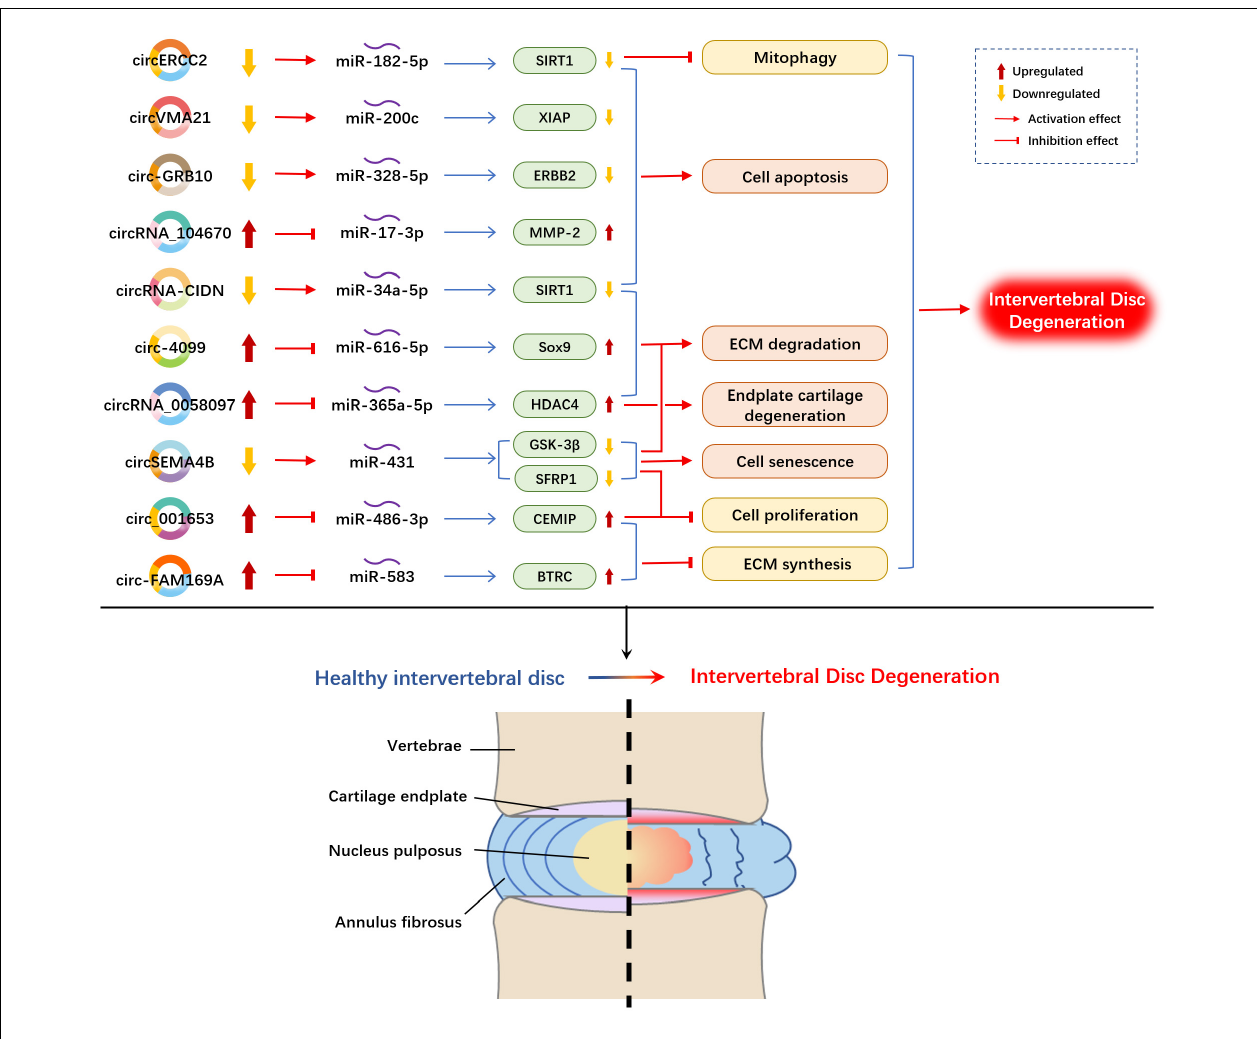
FIGURE 3 | Example of altered circRNA expression patterns and their biological effects in intervertebral disk degeneration. circRNA, circular RNA; ECM, extracellular matrix; SIRT1, silent mating type information regulation 2 homolog 1; XIAP, X linked inhibitor of-apoptosis protein; ERBB2, erb-b2 receptor tyrosine kinase 2; MMP, matrix metallopeptidase; Sox9, SRY-Box transcription factor 9; HDAC4, histone deacetylase 4; GSK-3 β , glycogen synthase kinase-3 β ; SFRP1, secreted frizzled-related protein 1; CEMIP, cell migration-inducing hyaluronan binding protein; BTRC, beta-transducin repeat-containing protein. TABLE 3 | circRNA/miRNA/mRNA networks in rheumatoid arthritis. Species Diseases Region circRNA Change miRNA Change Target